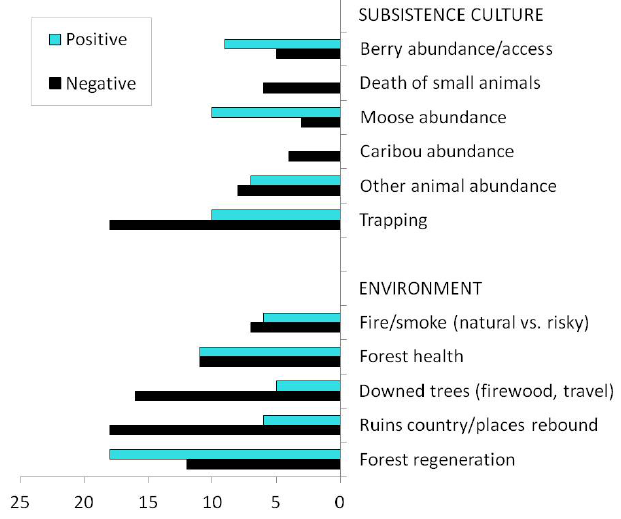
Fig. 5 . Koyukon respondent positive and negative comments about wildfire effects. Note that the numbers on the X-axis refer to the number of respondents who provided each